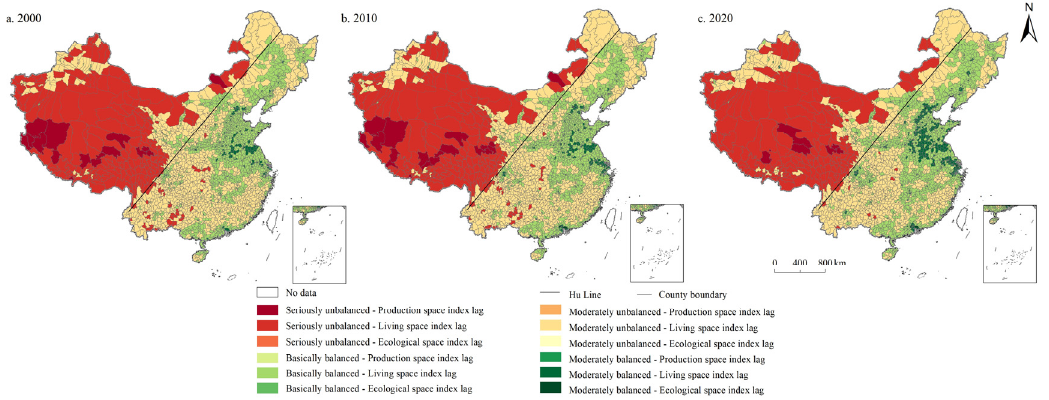
Figure 9. Spatial distribution of coordination degree of PLES index subcategory in China during